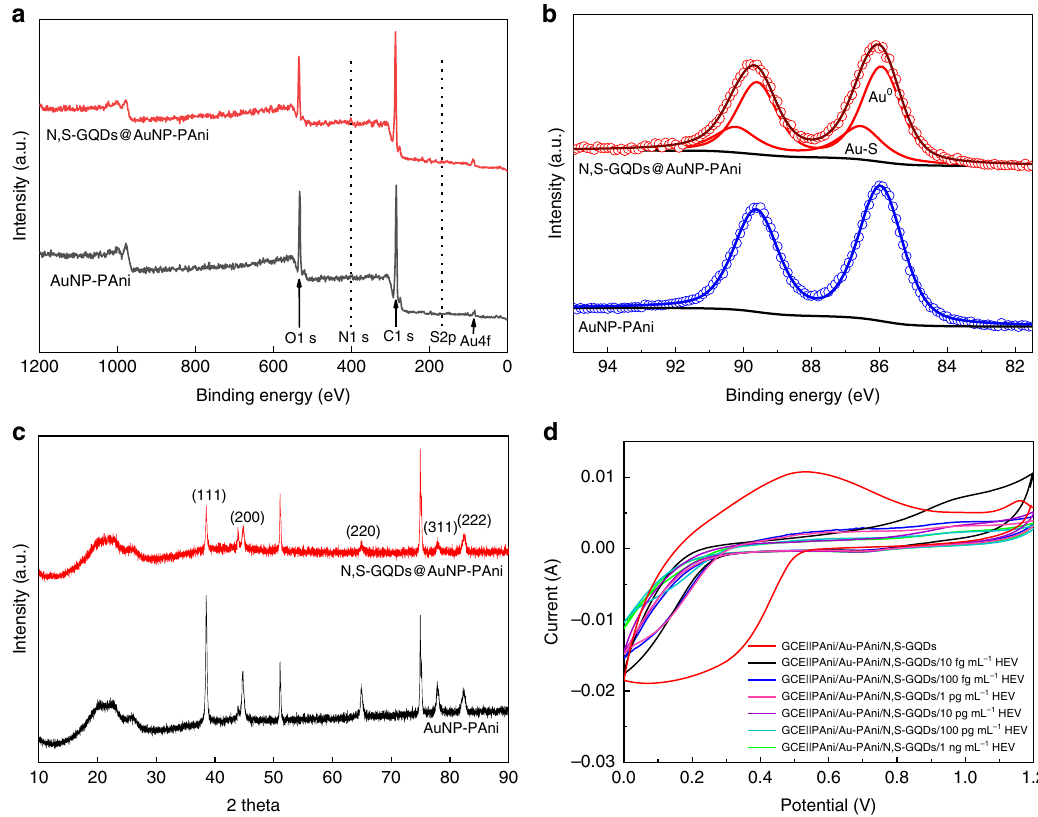
Fig. 3 Characterizations of N,S-GQDs@AuNP-PAni nanocomposites: a survey spectrum of XPS, b deconvoluted Au 4f spectra, c XRD of N,S- GQDs@AuNP-PAni nanocomposites before and after attachment of N,S-GQDs, and d cyclic voltammetry (CV) of the Ab-N,S-GQDs@AuNP-PAni/PAni|| GCE sensor electrode before and after the addition of different virus